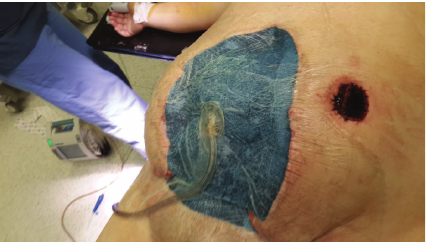
Figure 7: Double barrel jejunostomy and NPT application are seen.